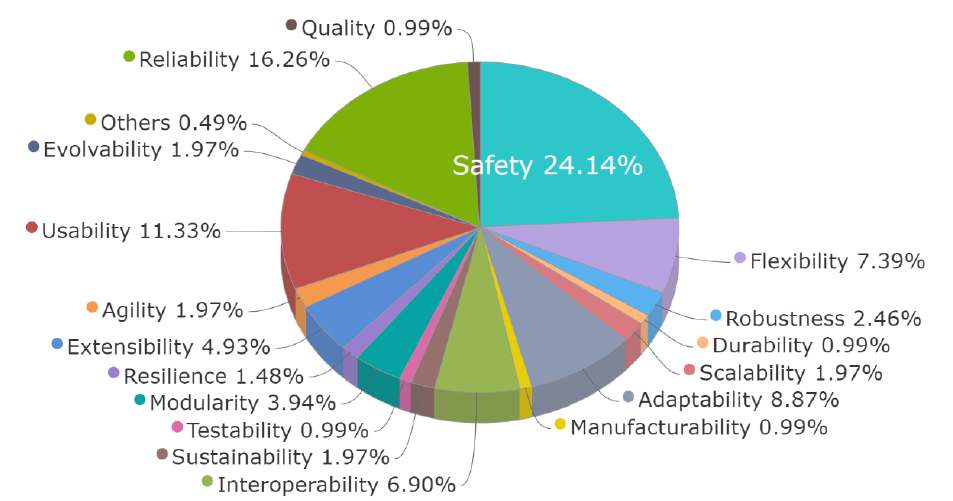
Figure 6. Life-cycle properties related to the studies.